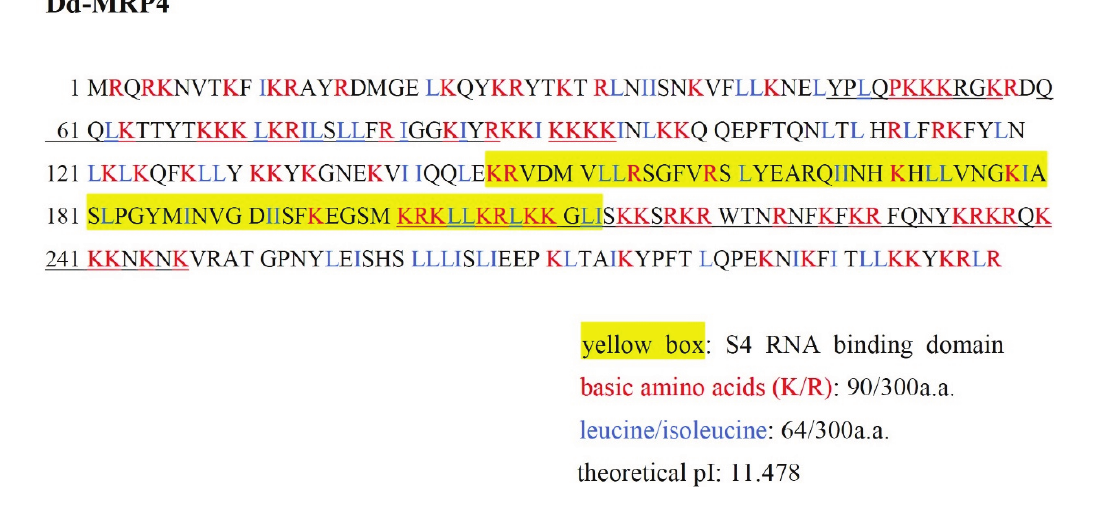
Figure 1. Unique structure of Dd-MRP4 molecule. Based on the presence of S4 RNA binding domain (yellow box), this molecule is categorized into ribosomal protein S4, though its amino acid sequence is markedly different from Dictyostelium cytoplasmic ribosomal protein S4 (Dd-RPS4) as a whole. Dd-MRP4 is highly basic (pI: about 11.5) because of the quite high contents of lysine (K) and arginine (R), and interestingly has several nuclear localization signals (underlined regions) within the